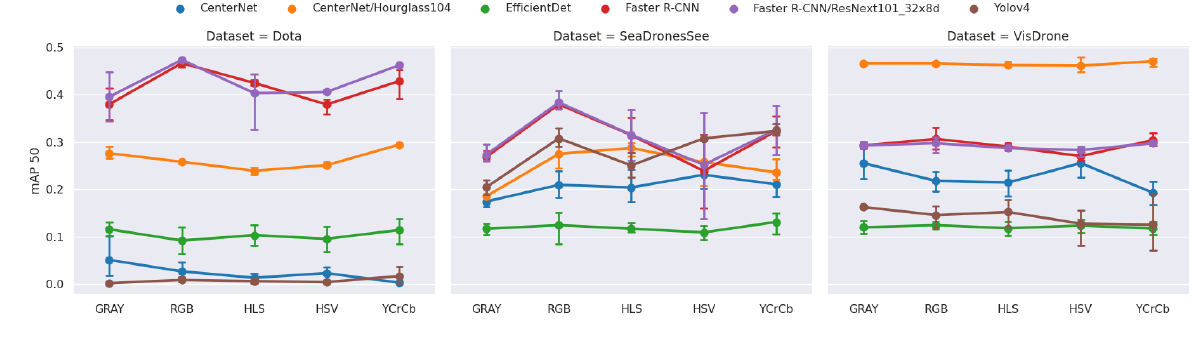
Figure 7. Color Model: the impact of the color models. The y-axis shows the mean Average Precision (mAP).